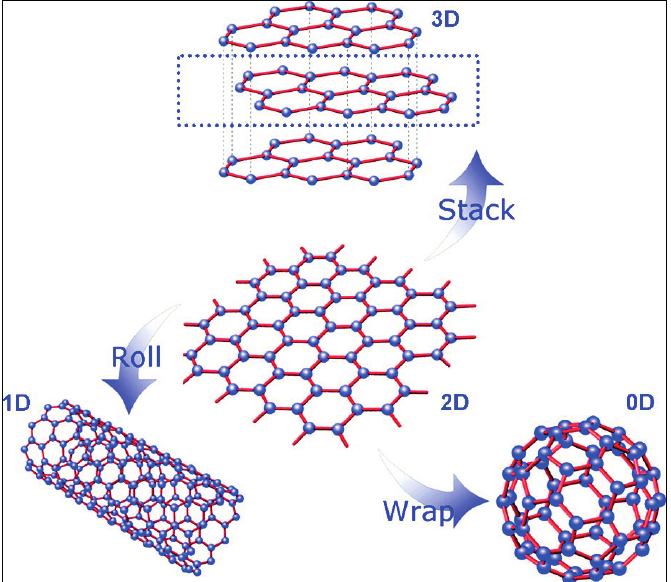
Figure 1. Graphene: the basic building block for other carbon allotropes, graphite (3D), fullerene (0D), and CNT (1D). Reprinted with permission from [18]. Copyright (2012) American Chemical